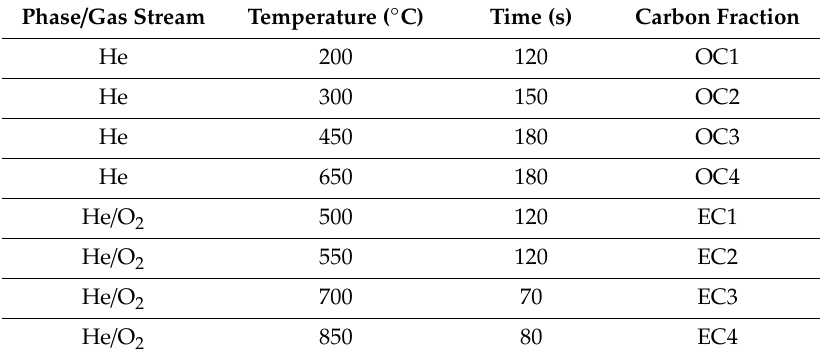
Table 2. Parameters of the analysis according with the EUSAAR 2 protocol. (OC1–4: four organic carbons, EC1–4: four elemental